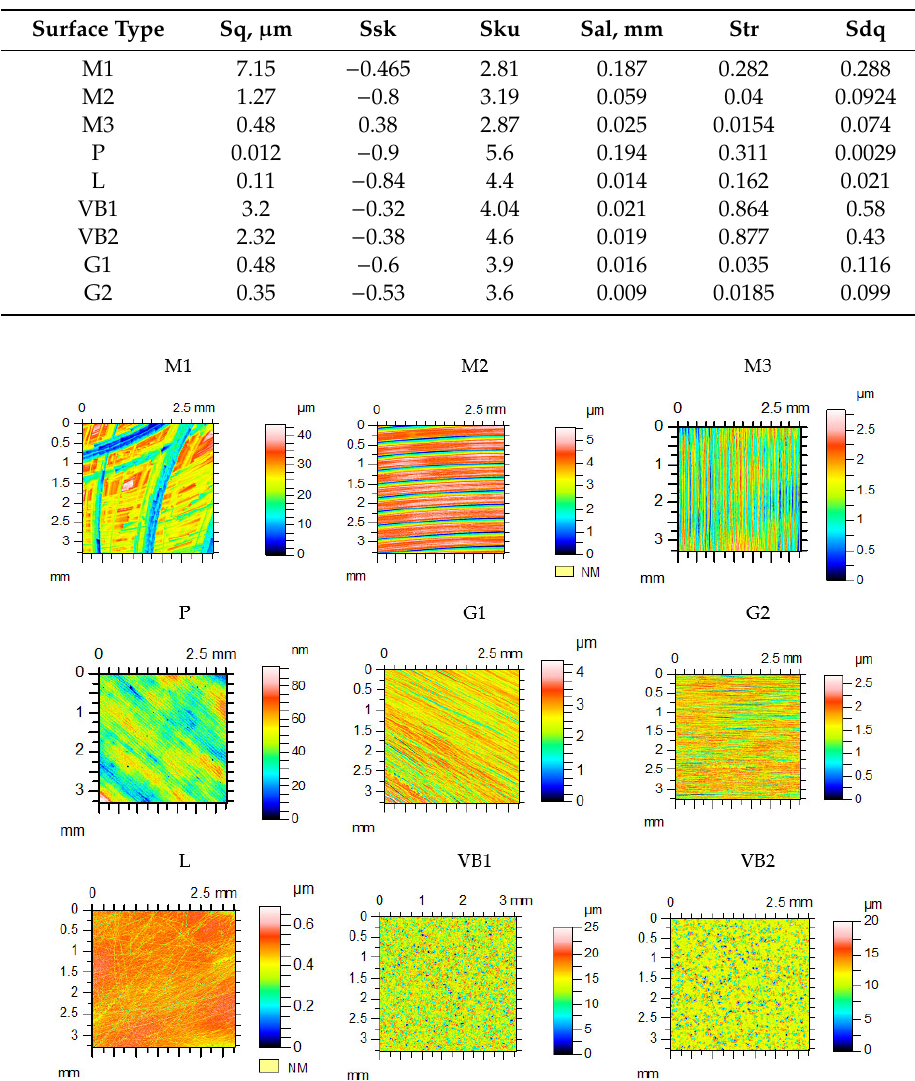
Table 2. Parameters of the tested disc surfaces.